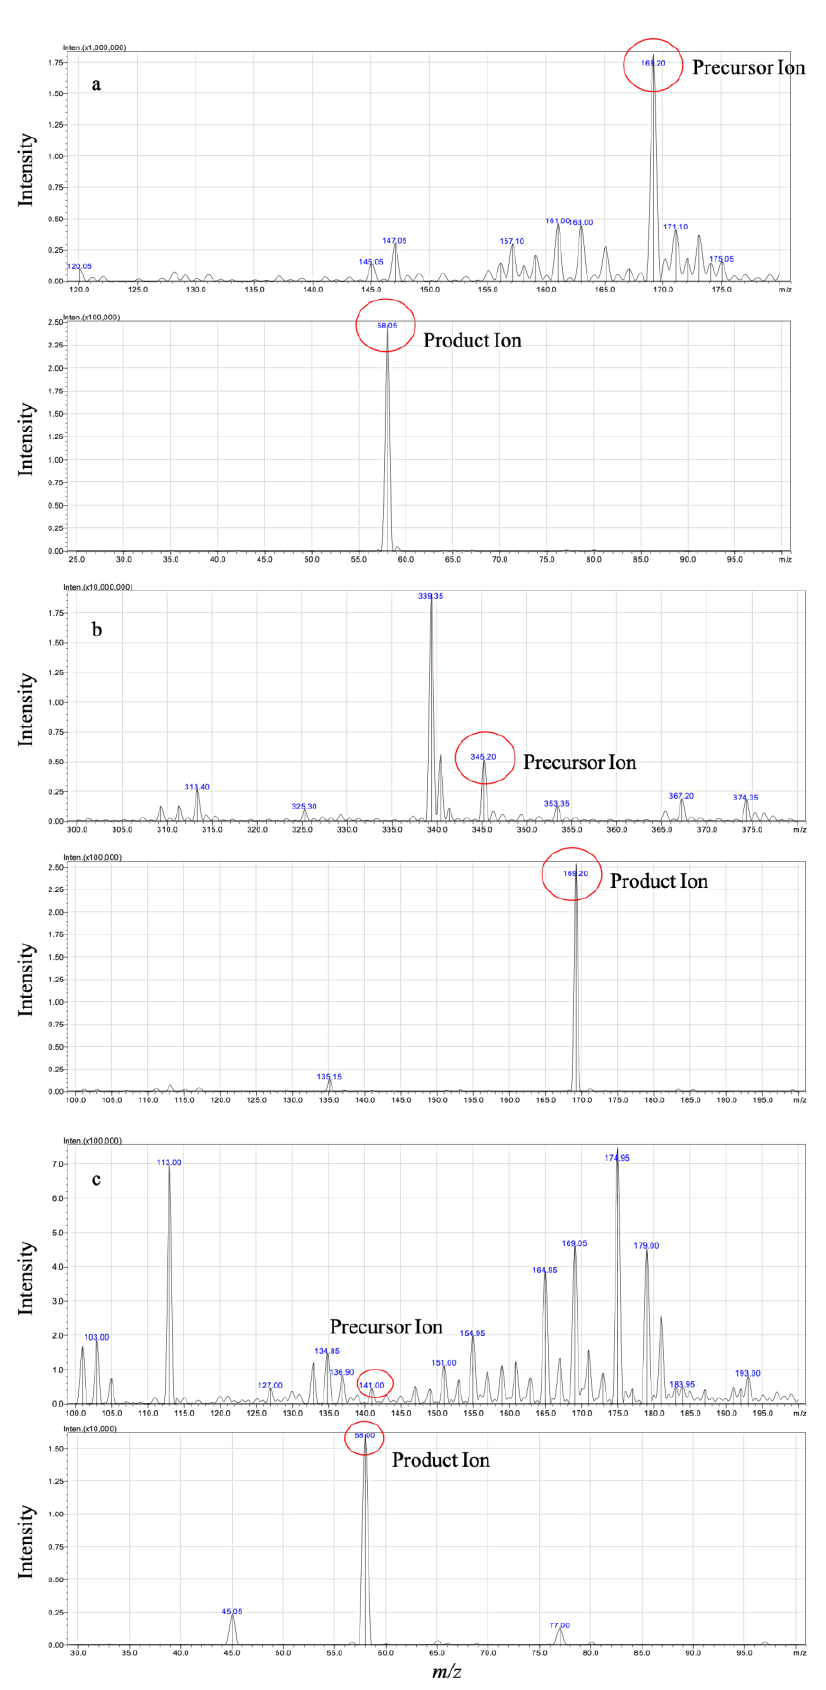
Figure 1. Mass spectra of PTU ( a ), PTU-GLU ( b ), and MTU ( c ) in ESI mode.